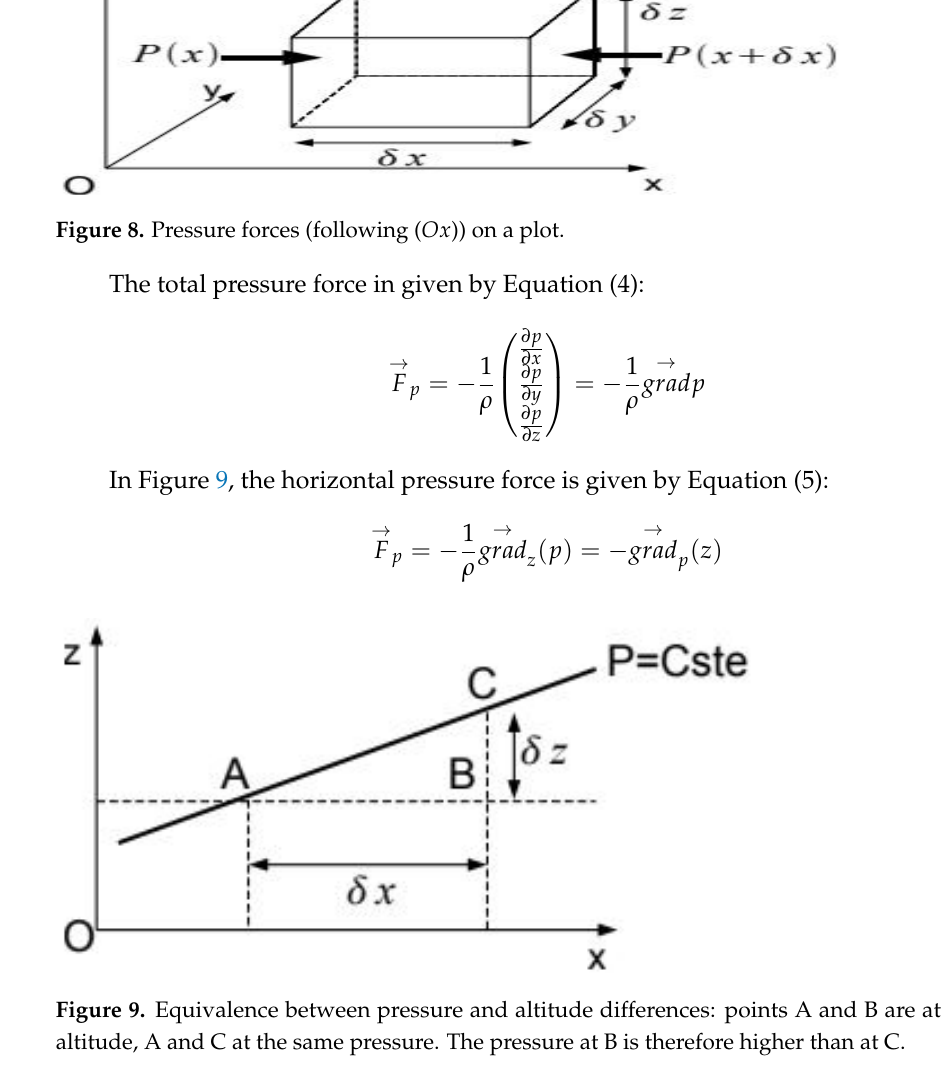
Figure 8. Pressure forces (following ( 𝑂𝑥 )) on a plot.